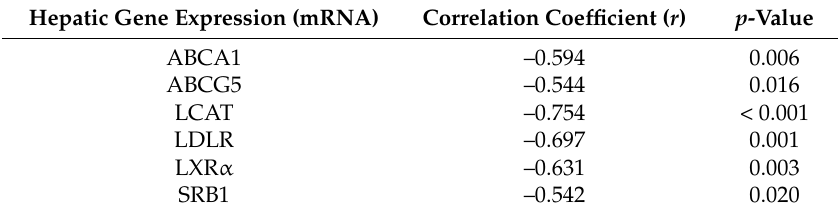
Table 3. Correlation between serum GPT level and hepatic expressions of genes related to cholesterol